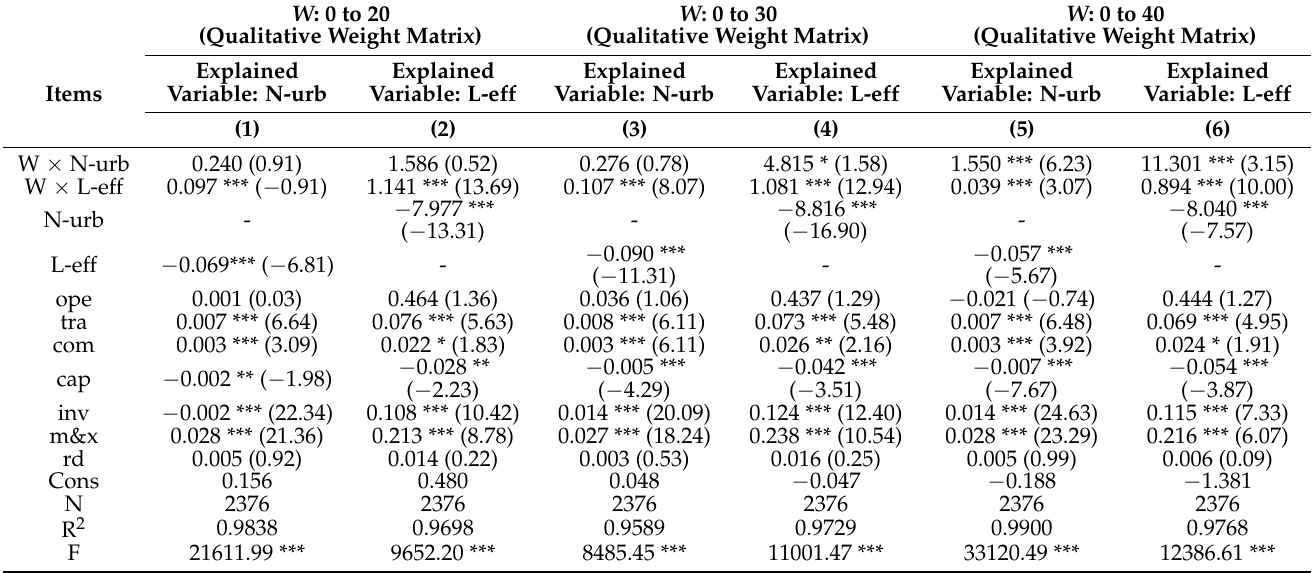
Table 8. Robustness test of adjusting the spatial weighted matrix